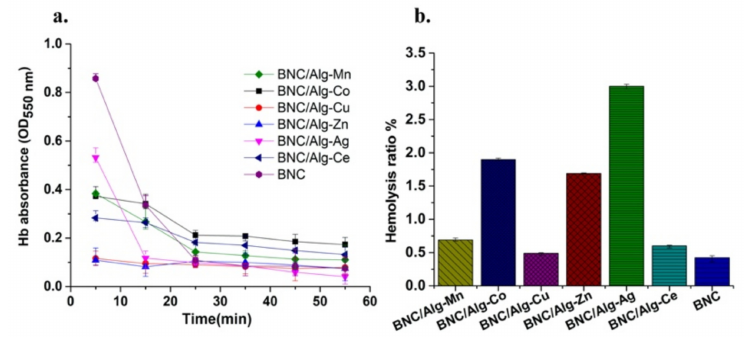
Figure 5. ( a ) Whole blood clotting presented by Hb (Hemoglobin) absorbance at 550 nm, ( b ) in vitro hemolytic rate of synthesized dressing